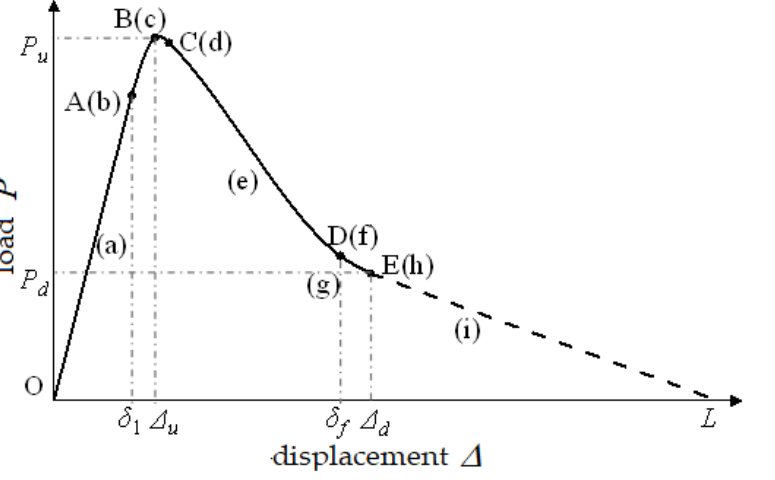
Figure 16. Full-range analytical load–displacement curve of single fibre pullout with short em- bedment length (not up to the real scale).